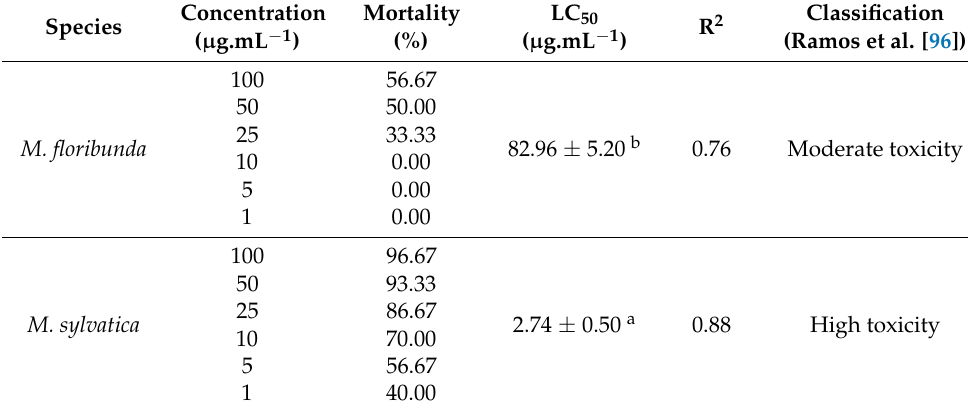
Table 2. Preliminary cytotoxicity of essential oils. Concentration Species ( µ g.mL − 1 )